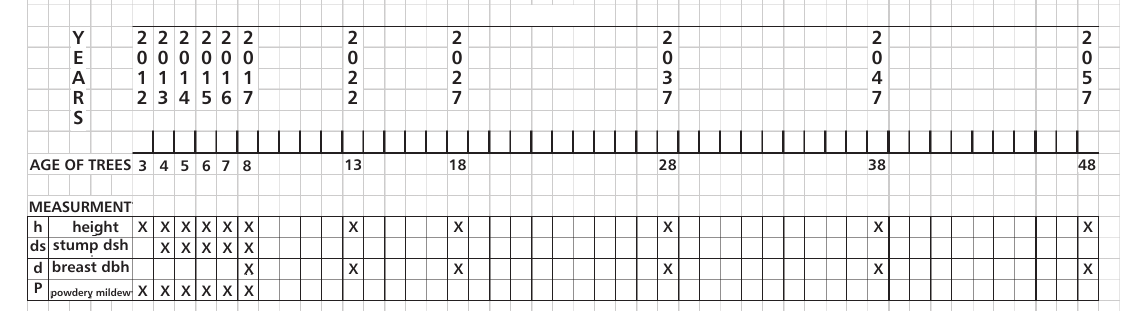
FIGURE 2 Timeline on trees’ measurement in the period from 2012. till